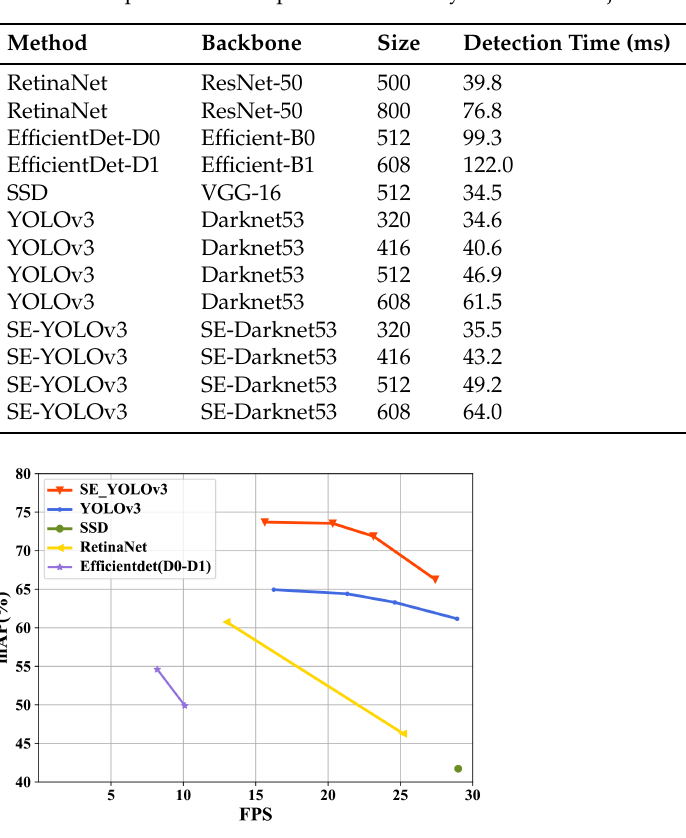
Table 3. Comparison of the speed and accuracy of different object detectors on the PWMFD.